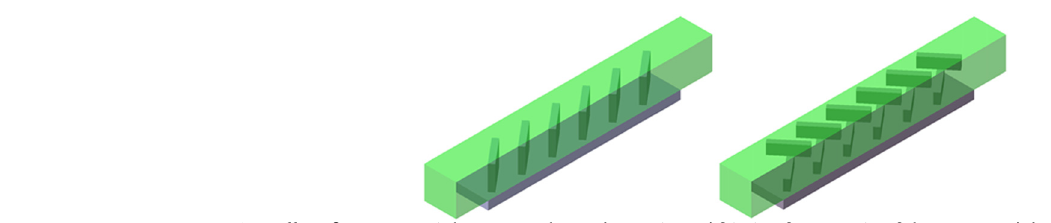
Design: Surface roughness and fl ow disruption